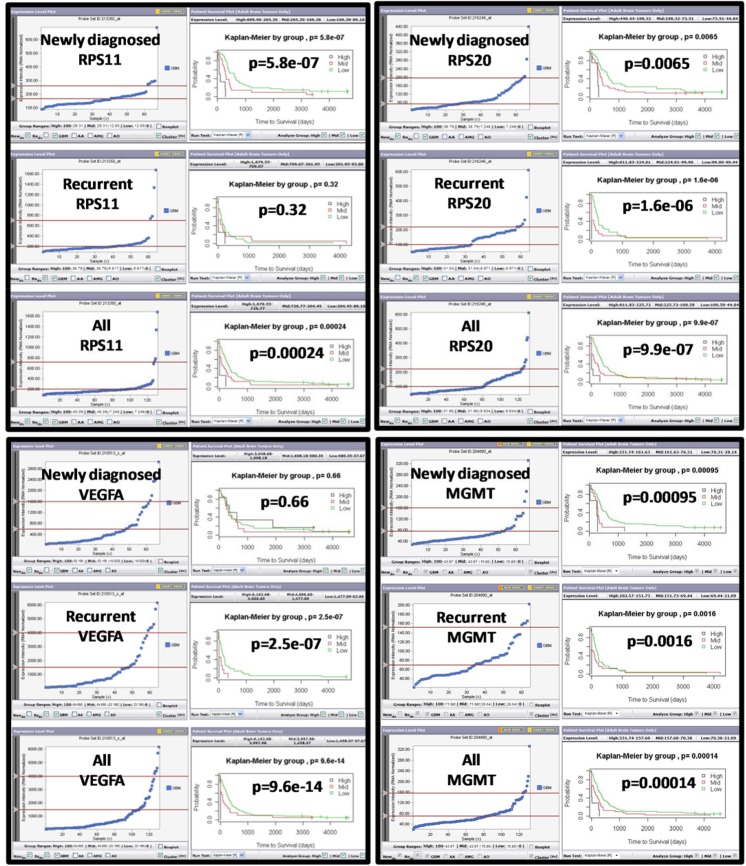
Representative outputs of Probe Set Analyzer for selected molecular signatures of TRGC.A real-time correlation of patient survival and gene expression levels of selected signatures of TRGC was performed using Probe Set Analyzer (http://probesetanalyzer.com/index.aspx). “Newly Diagnosed", “Recurrent" or “combined all tumors” were analyzed. The y-axis represents normalized gene expression intensity, and the x-axis represents patient groups. The sliding bars position patients into high, mid and low gene expression level groups. A Kaplan-Meier curve with corresponding p-values is generated based on each change to these patient groups. An integrated statistical engine calculated p-values based on Kaplan-Meier curves.